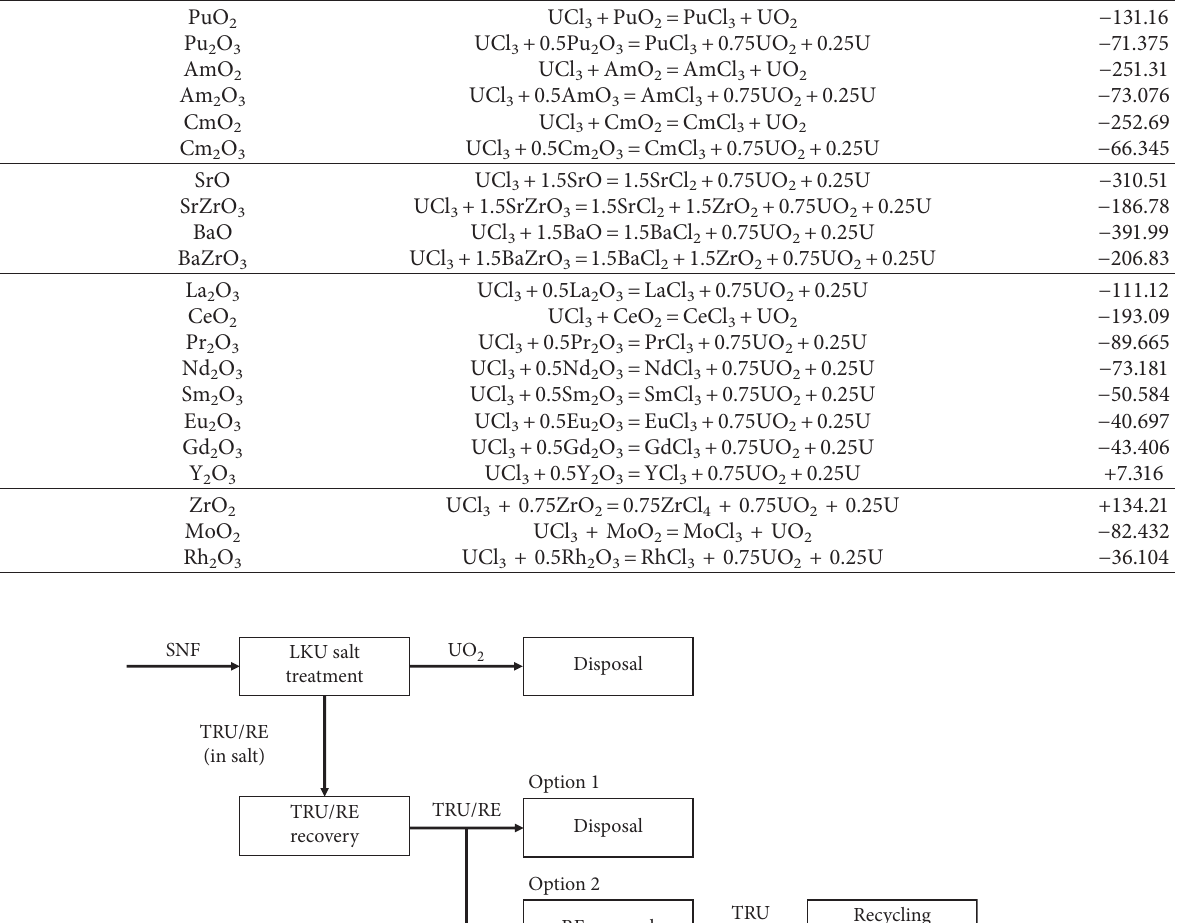
Figure 1: Photographs of the experimental procedure of the immersion test. Table 2: Thermodynamic calculation results of chemical reactions between UCl Category